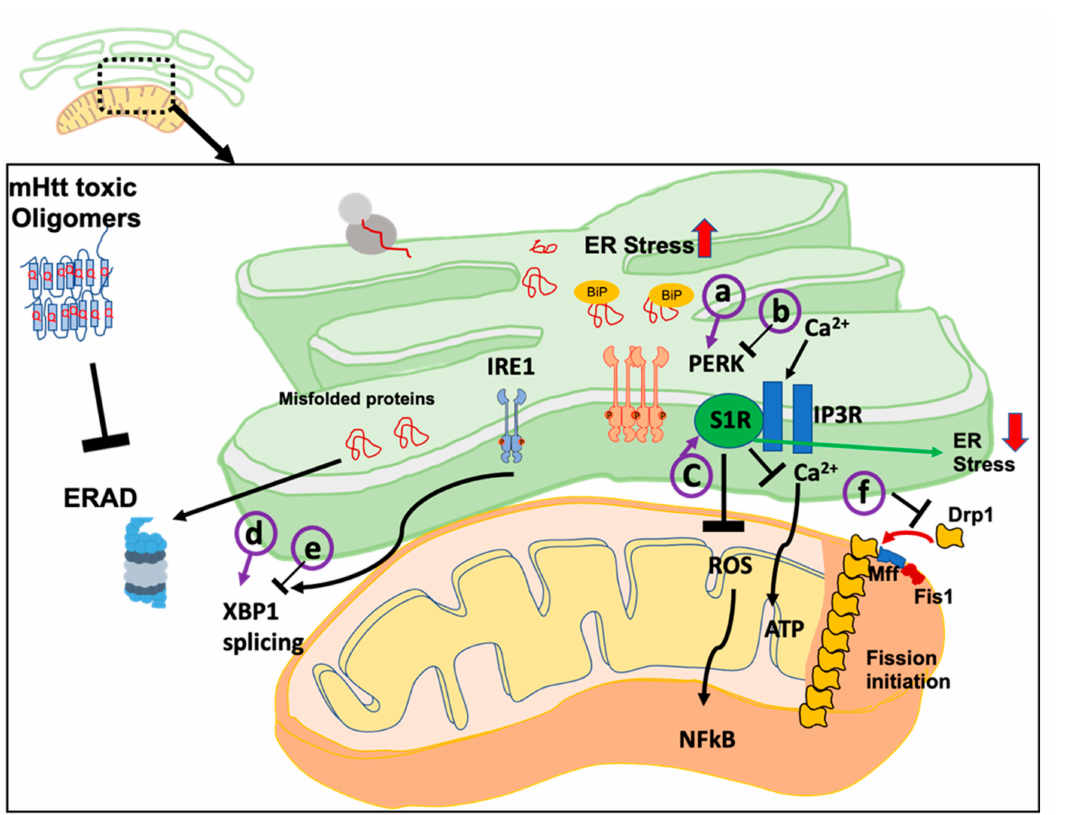
Figure 2. ER stress sensor proteins and MAM proteins as therapeutic targets in HD. Inhibition of ERAD by mHtt toxic oligomers can induce ER stress. ER stress sensors (like IRE1, PERK) sense proteostasis imbalance activates unfolded protein response pathways. The a, b, c, d, e & f indicate possible points of therapeutic intervention either at the level of ER stress sensor or MAM